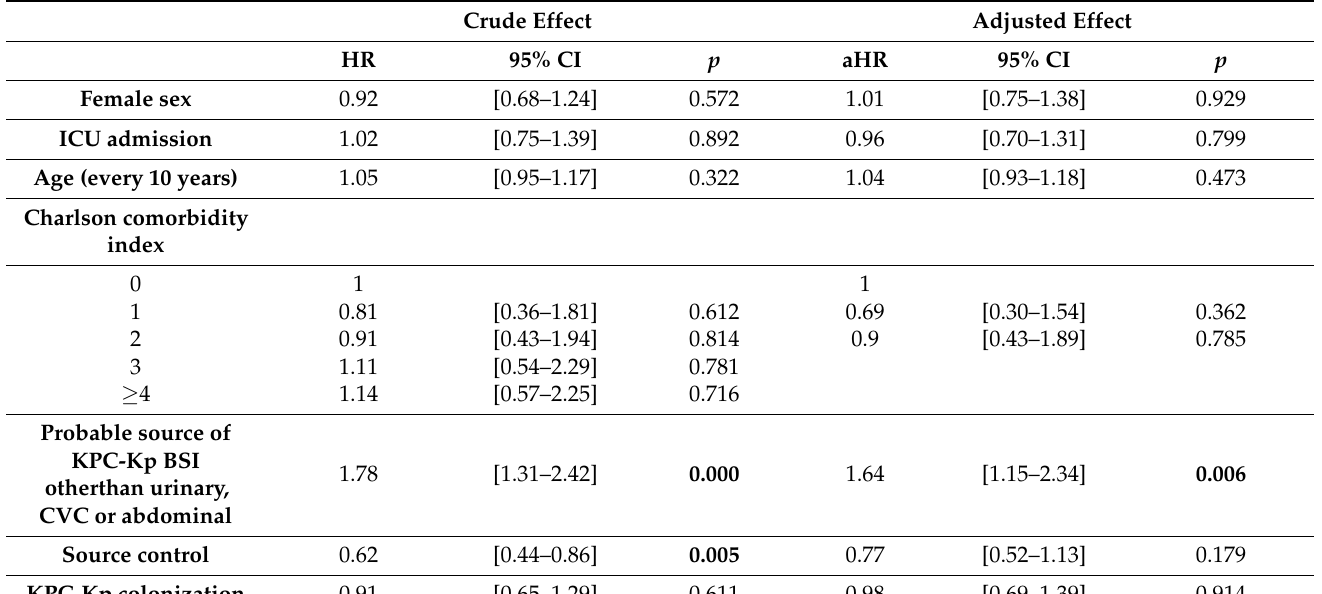
Table 4. Crude and adjusted effects of the predictors of mortality ( n =